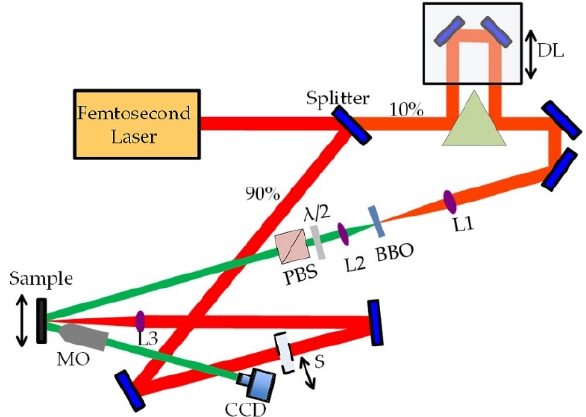
Figure 1. Scheme of the experimental setup. Abbreviations: DL—delay line; L—lens; BBO—nonlinear crystal; λ /2—halfwave plate; PBS—polarized beam splitter; MO—microscope objective; CCD— camera; S—beam shutter.